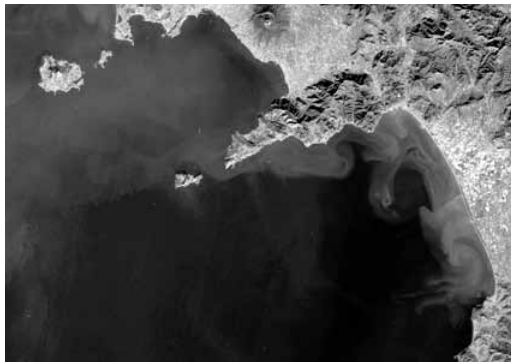
Fig. 4. The Landsat 8 OLI panchromatic image Fig. 5. The regular grid of